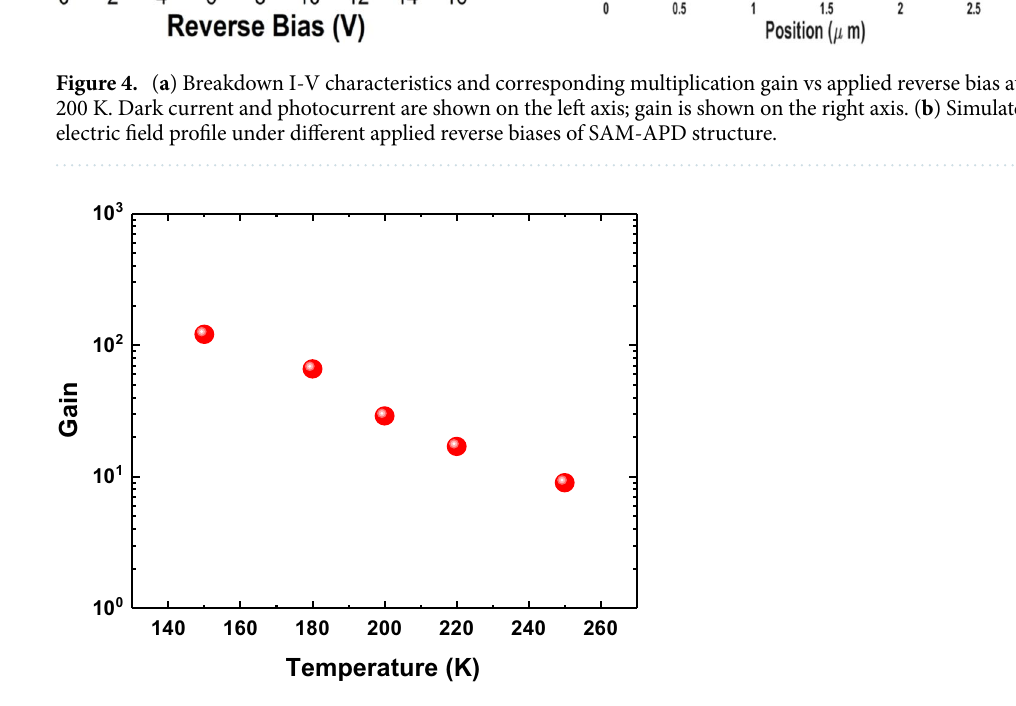
Figure 5. Temperature dependent gain characteristics of the InAsSb-based MWIR